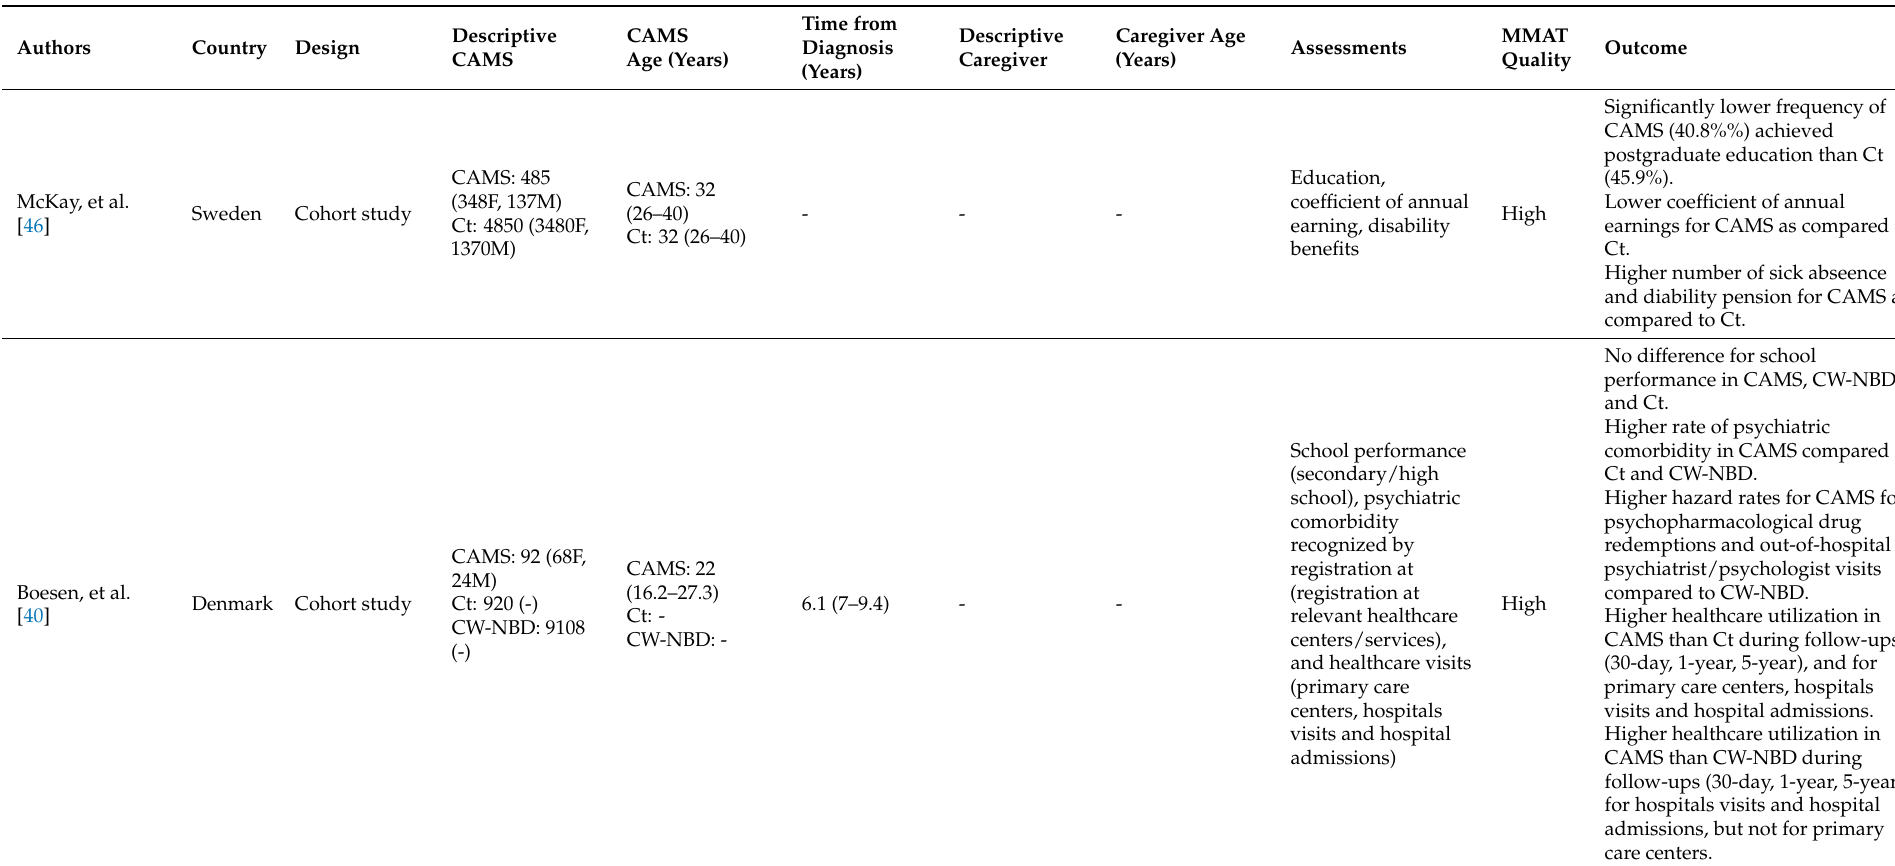
Table 1. Illustrates the Grade-CERQual criteria from the included studies for the experiences of